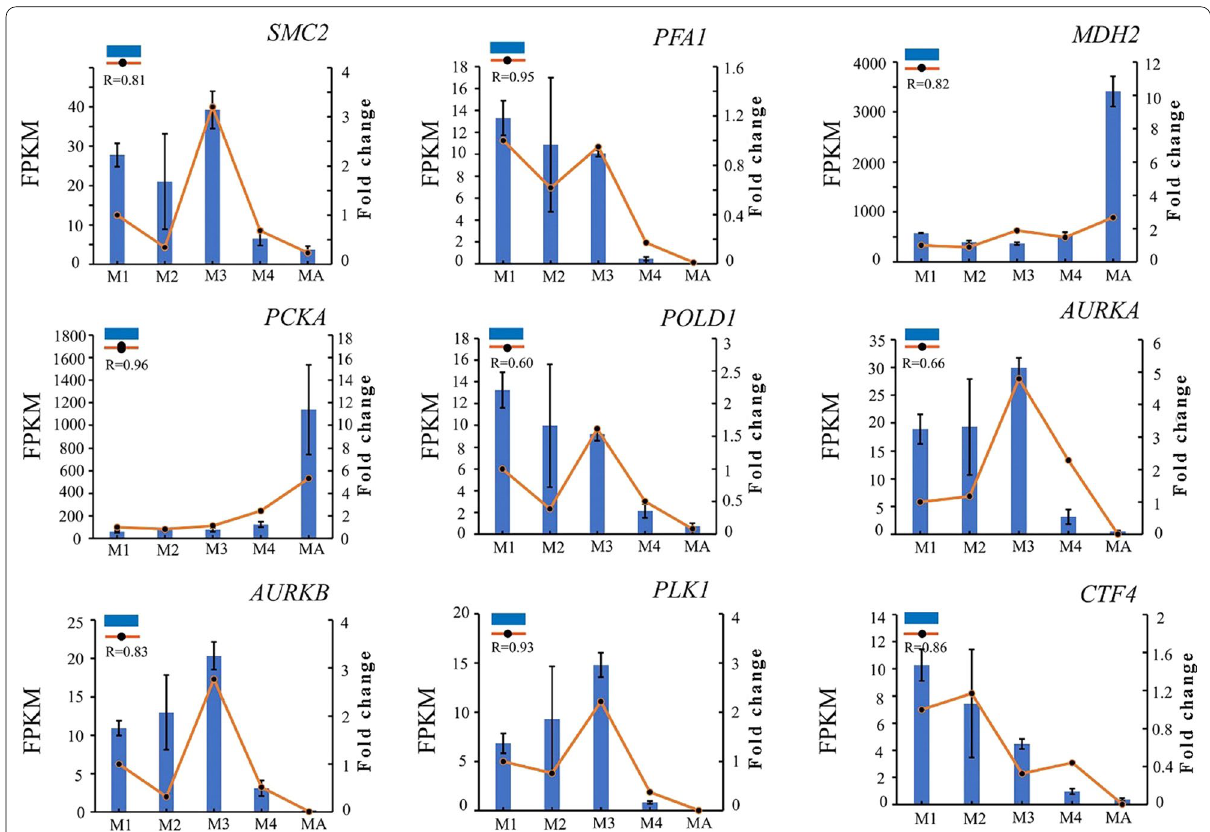
Fig. 11 Quantitative qRT-PCR of 9 DEGs in male cotton aphids. The genes expression level at M1 stage was used as a control for normalization. Pearson correlation coefficients were calculated by comparing results between qRT-PCR and RNA-seq data for each